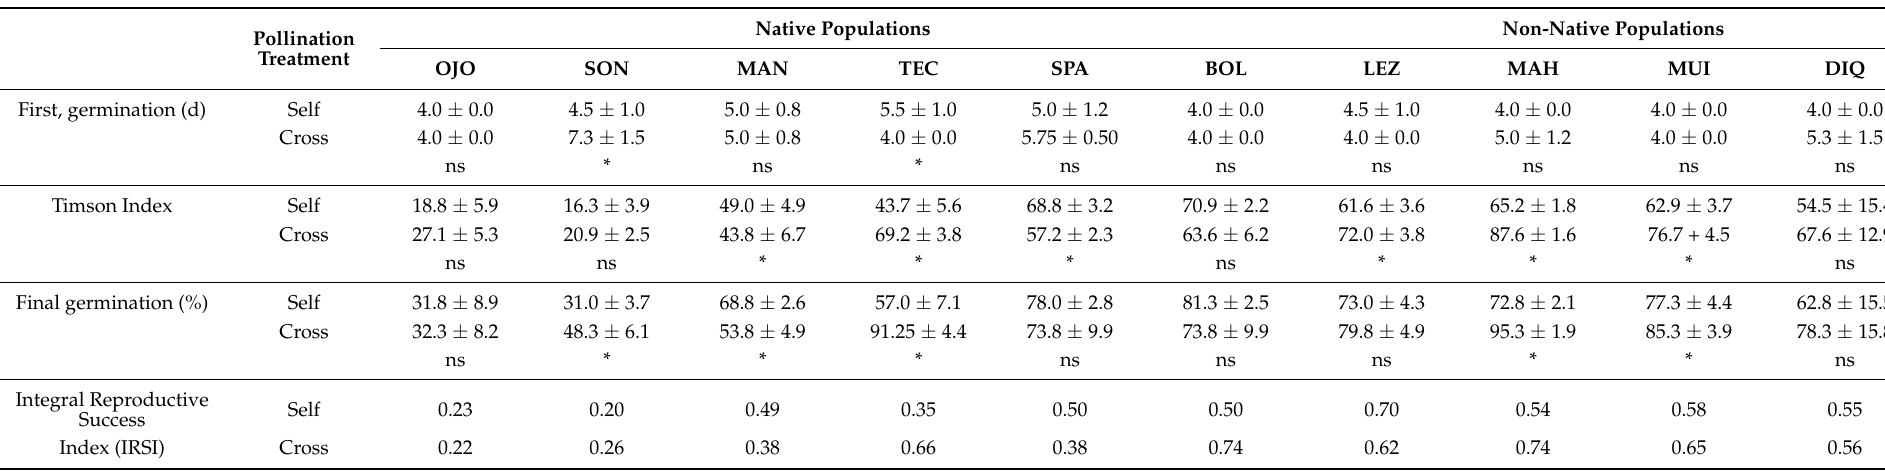
Table A3. Seed germination characteristics and the integral reproductive success index (IRSI) of self- and cross-pollination treatments in flowers of native and non-native populations of Oenothera drummondii . The last row of each germination parameter shows the comparison (Wilcoxon test) between self- and cross-pollination data of each population (ns = not significant; * p = 0.05). Population acronyms provided in Figure 1and Table